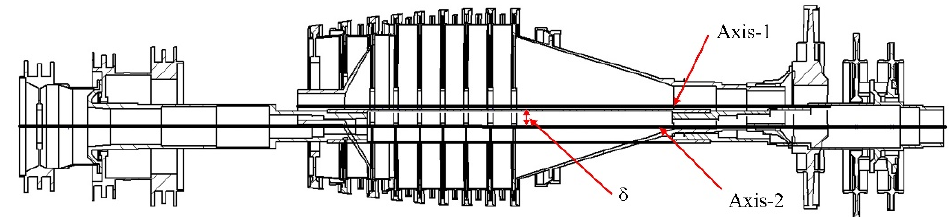
Figure 10. Parallel non-concentricity of dual-rotor.